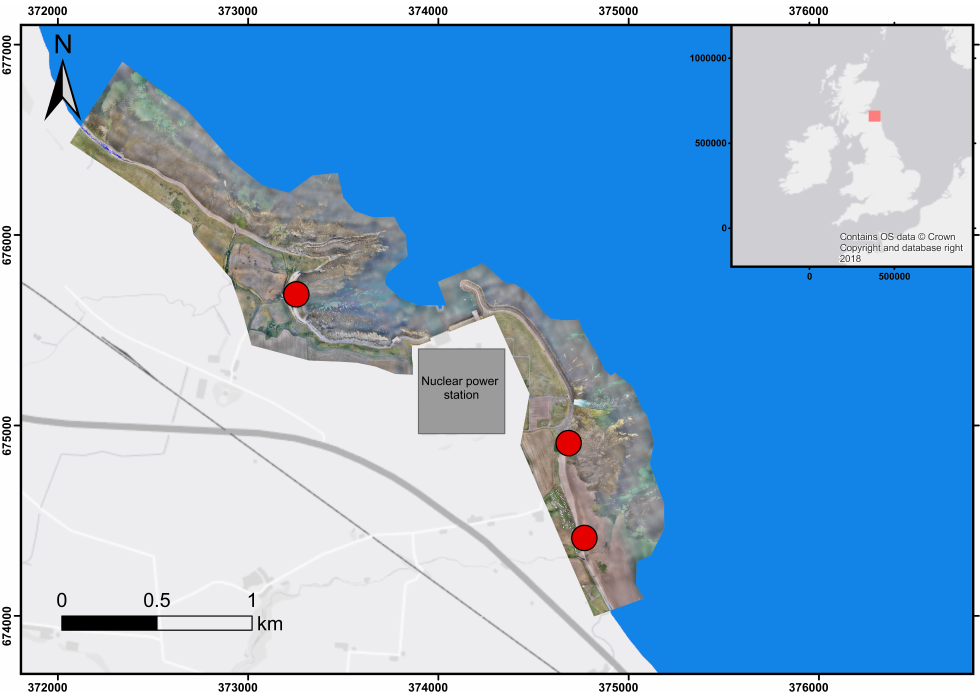
Figure 1. Hybrid map of the study site with orthoimage of the coastline embedded. The nuclear power station is Torness, Scotland, UK (EDF Energy). Red markers show the location of the sampling sites. Coordinates used from the British National Grid system. Contains OS data c (cid:13) Crown copyright and database